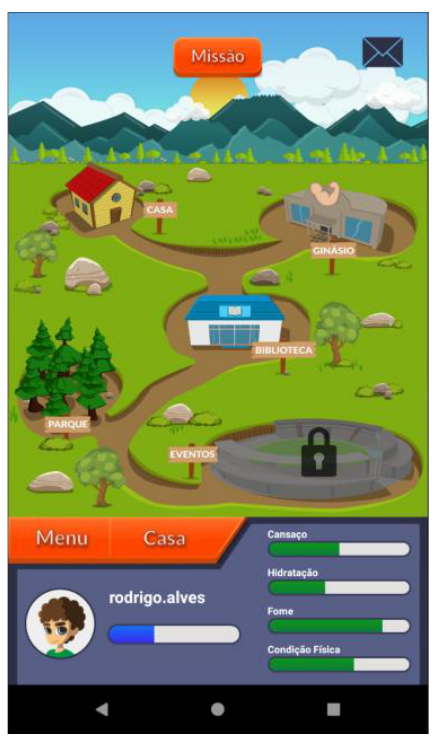
Figure 3. Dashboard—navigation map that holds: the user home (“casa”), the gym (“ginásio”), the library (“biblioteca”) and the park (“parque”)—affordance; legibility.